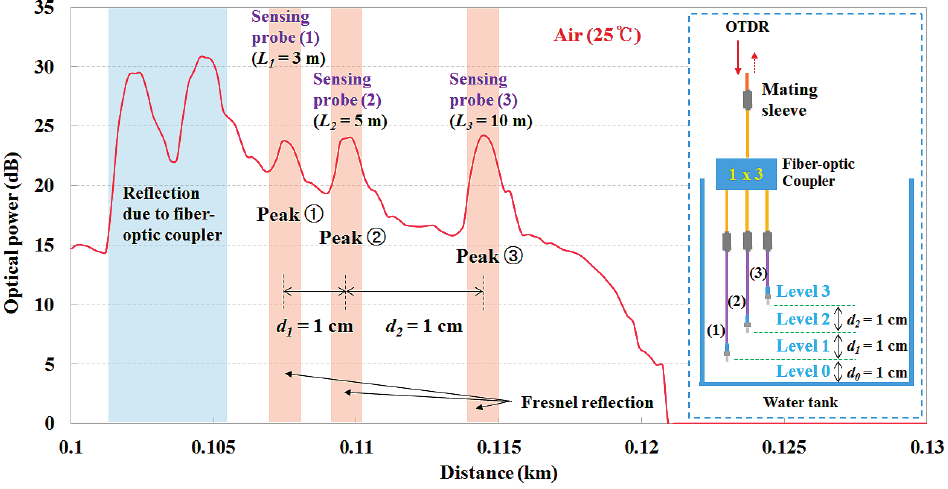
Figure 9. Individual light signals reflected from three sensing probes exposed to air with a temperature of 25